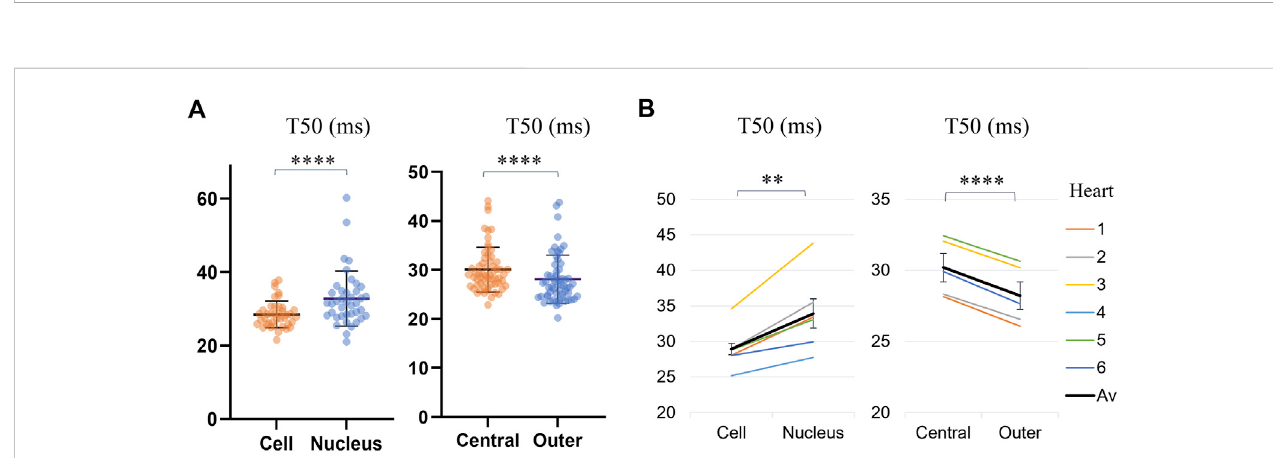
FIGURE 5 Comparison of average time-to-half-maximum (T50) for different regions of the cell: the cell (excluding the nucleus), the nucleus, the central IQR and the outer quarters. (A) Transient T50 distributions, with each datapoint corresponding to the median across all pixels within a region of a cell. The horizontal lines indicate the mean ± SD over all cells ( n = 40 for cells with identi fi ed nuclei for the fi rst category, and all n = 60 cells for the second category. Levels of signi fi cance illustrated with stars are based on paired testing (see Supplementary Table S3). (B) Transient T50 in different regions of each cell, averaged over the cells from each heart (1 – 6, see legend). The overall average ( “ Av ” ) across the six hearts is shown in black. The error bars represent the standard errors (SE = SD/ √ n) across the heart averages. When comparing cell-by-cell differences, averaged for each heart using a one-sample t -test, both comparisons maintained statistical signi fi cance, with the nuclei and central regions of the cell having a signi fi cantly longer time-to-half-maximum than the rest of the cell and the outer region